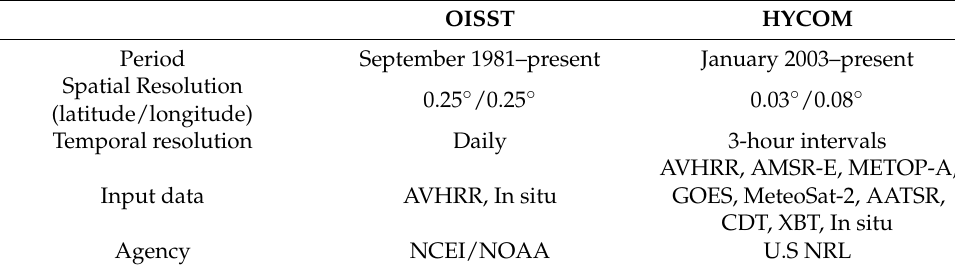
Table 2. Characteristics of two datasets used in this